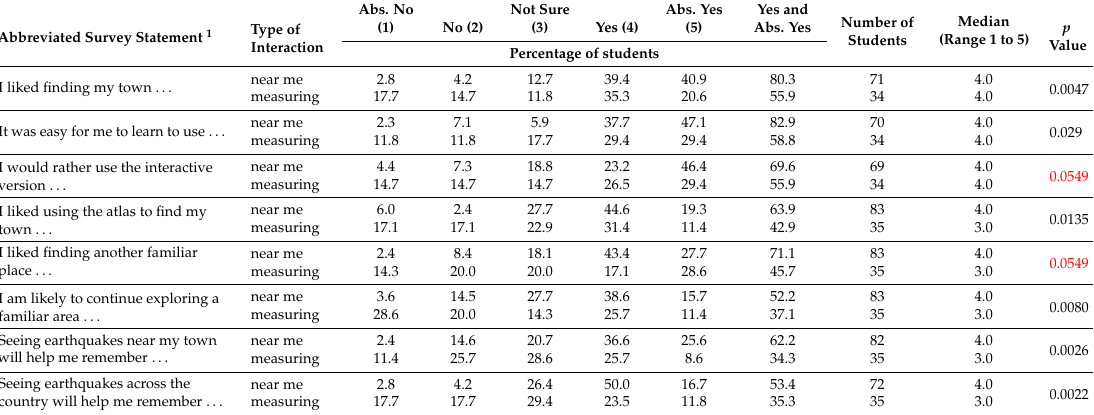
Table 4. Responses of two groups of students ages 11–12 to survey statements. The first group used a “near me” interactive tool and the second group used a measuring